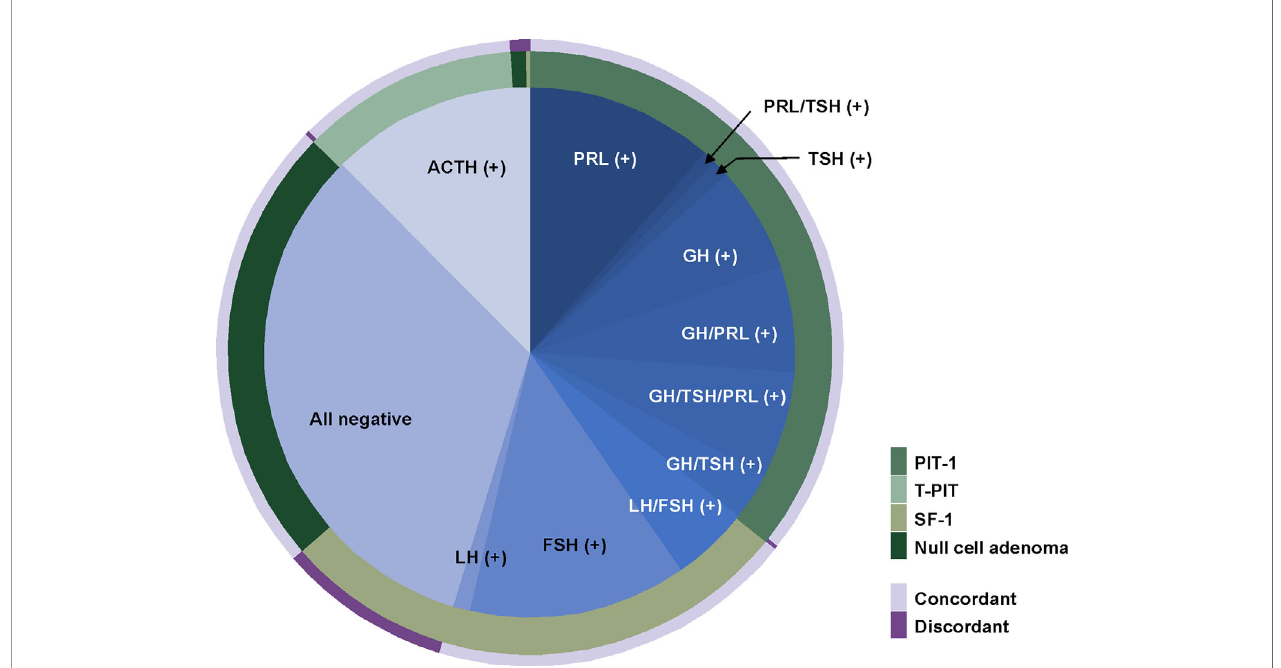
FIGURE 3 | Comparison between immunohistochemical stain for transcription factors and pituitary hormones. The most common subtype was PIT-1 positive adenomas. In 171 PIT-1 positive adenomas, the most prevalent subtype was a prolactinoma followed by GH-positive tumors. The most common subtype of gonadotroph adenomas was a FSH-positive tumor and LH-positive tumors were the least common. Overall, 10.4% of cases showed discordance between TF stains and pituitary hormone stains. The majority of mismatched cases were gonadotroph adenomas of which stains were positive for SF-1 but negative for both FSH and LH. FSH, follicle stimulating hormone; GH, growth hormone; LH, luteinizing hormone; PIT-1, pituitary speci fi c transcription factor 1.